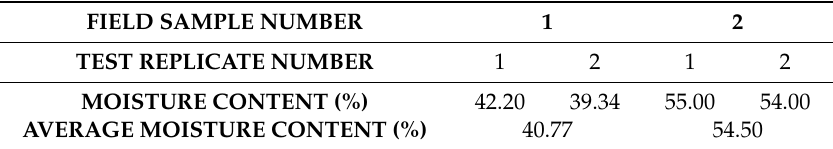
Table 3. The laboratory test results of the natural moisture content of the